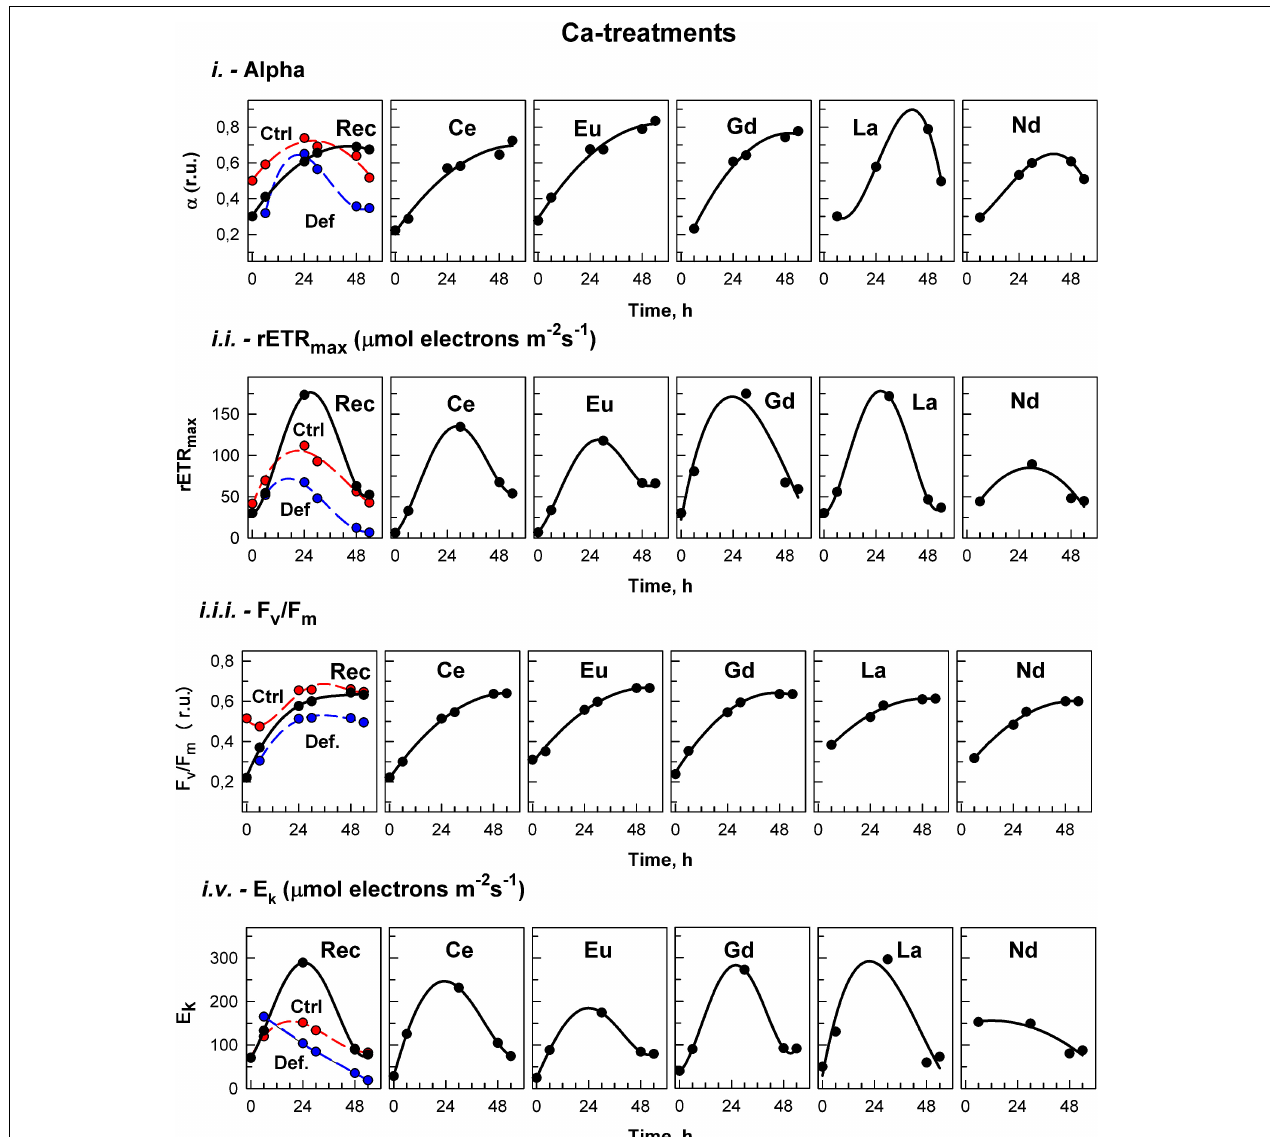
FIGURE 3 | Calcium treatment. The photosynthetic parameters in cultures of the alga Desmodesmus quadricauda grown either in complete mineral medium (Ctrl, red symbols, dashed curve) or in calcium- deficient mineral medium (Def, blue symbols, dashed curves) are shown. To calcium deficient cultures either the complete mineral medium was added (Rec, black symbols, solid line) or different